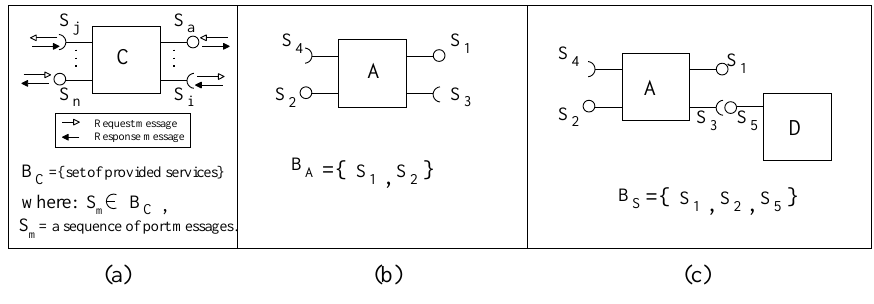
Figure 5. ( a ) Component definition, ( b ) Component behaviour, and ( c ) System